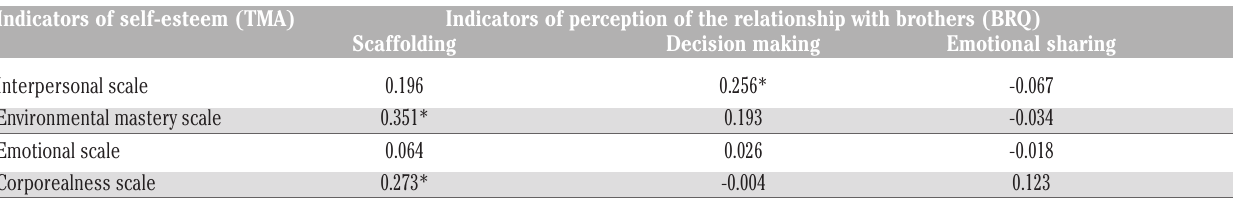
Table 5. Regressions for the TMA ( test multidimensionale dell'autostima ) corporealness scale. Independent variables